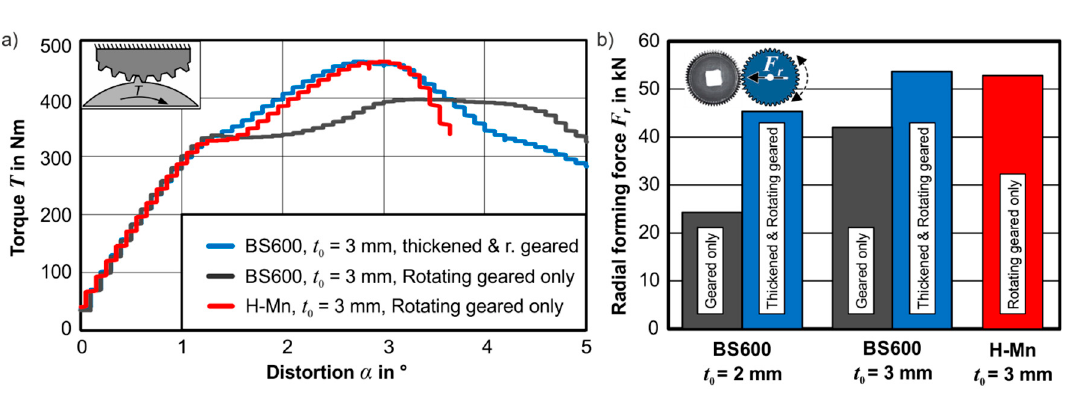
Figure 11. ( a ) Torque-distortion-curves and ( b ) comparison of the maximal radial forming force F r of gears made of different steel grades with modulus m = 1.5 mm.